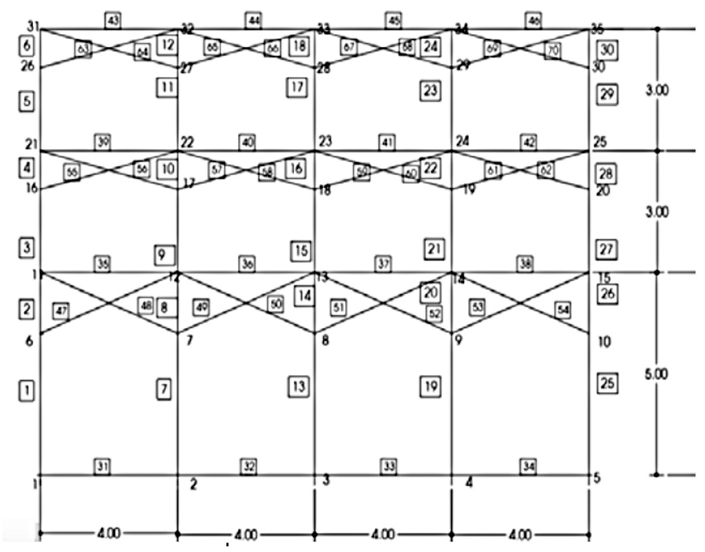
Figure 6. Model of the original building walls.